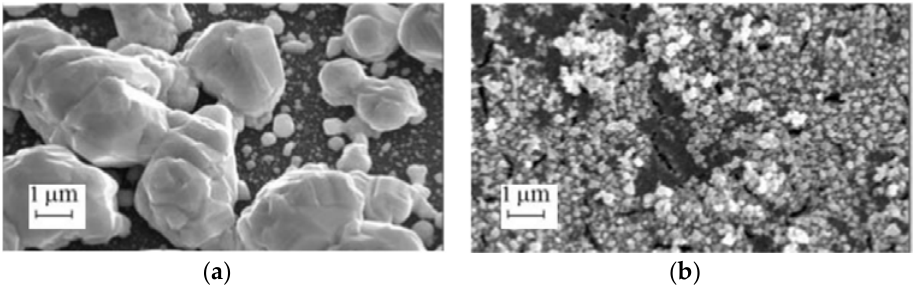
Figure 5. The SEM top views of porous silicon coated with silver for 10 min from the solutions with silver nitrate concentration of ( a ) 0.1 M and ( b ) 0.01 M.